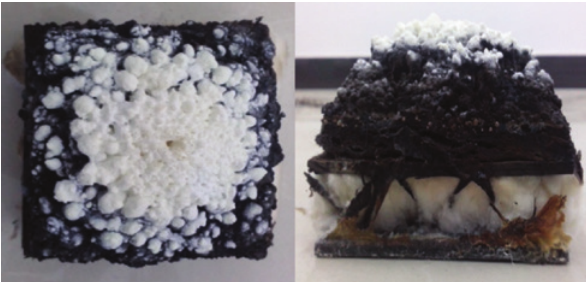
Figure 9: Photographs of fire-proofing composite lattice sandwich structure after test.